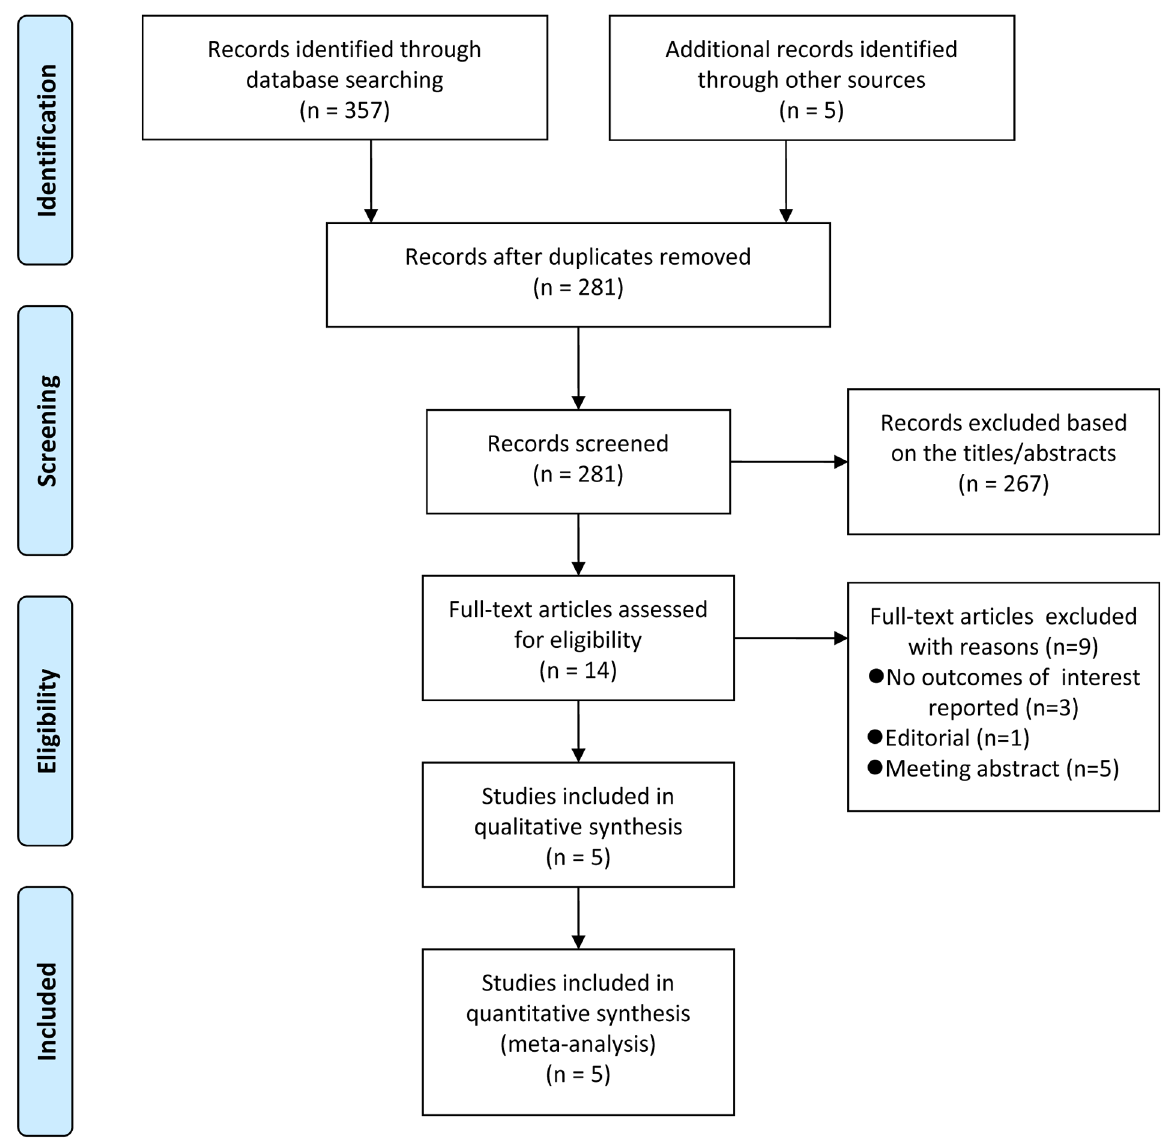
Fig 1. Flow diagram for selection of